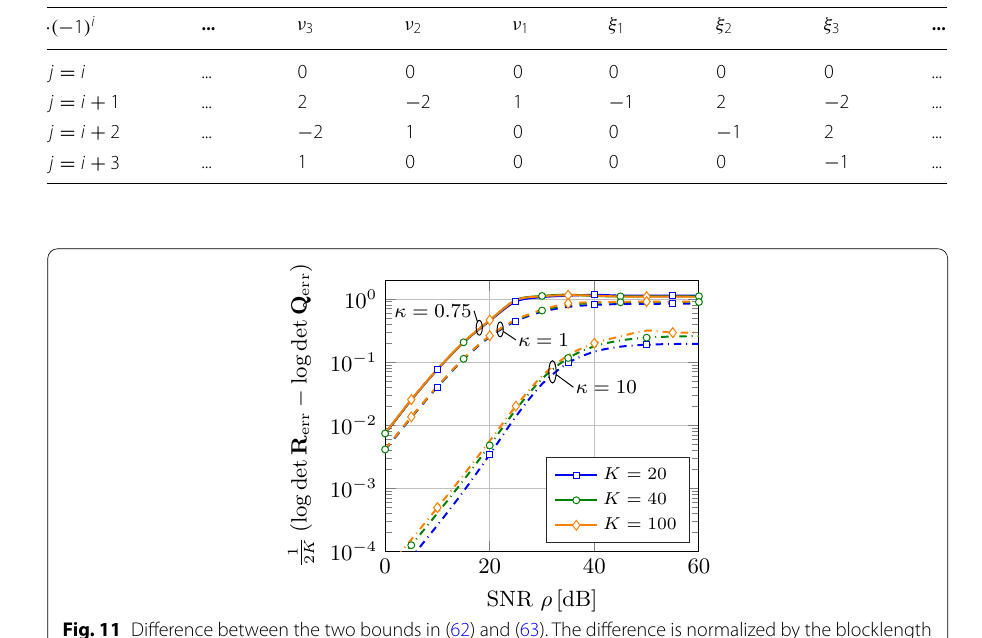
Table 1 Weights for computing the entries of cross-covariance matrix Q A